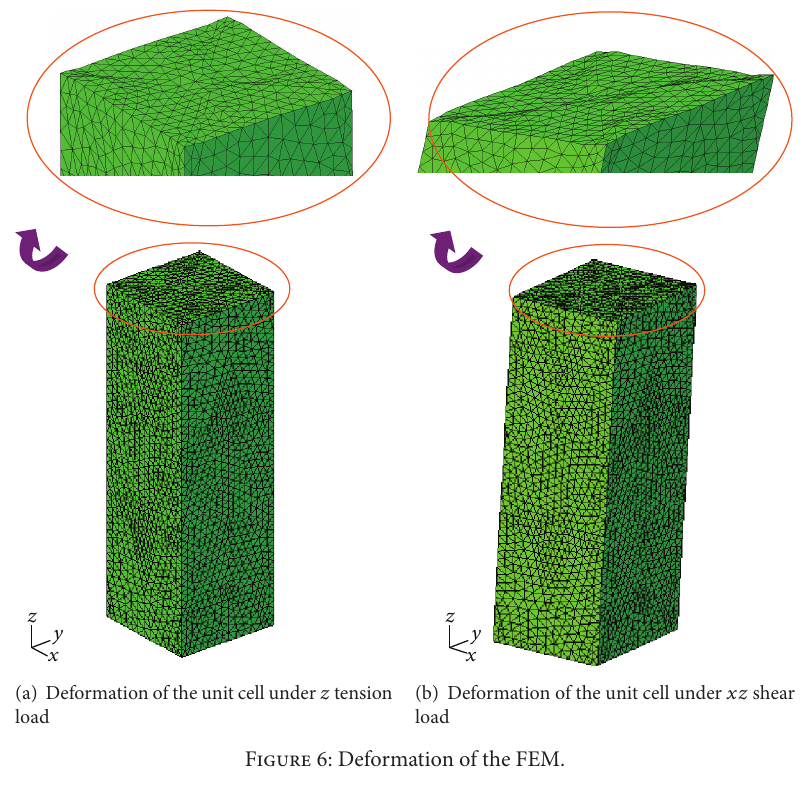
Figure 5: Stress nephogram of the FEM.